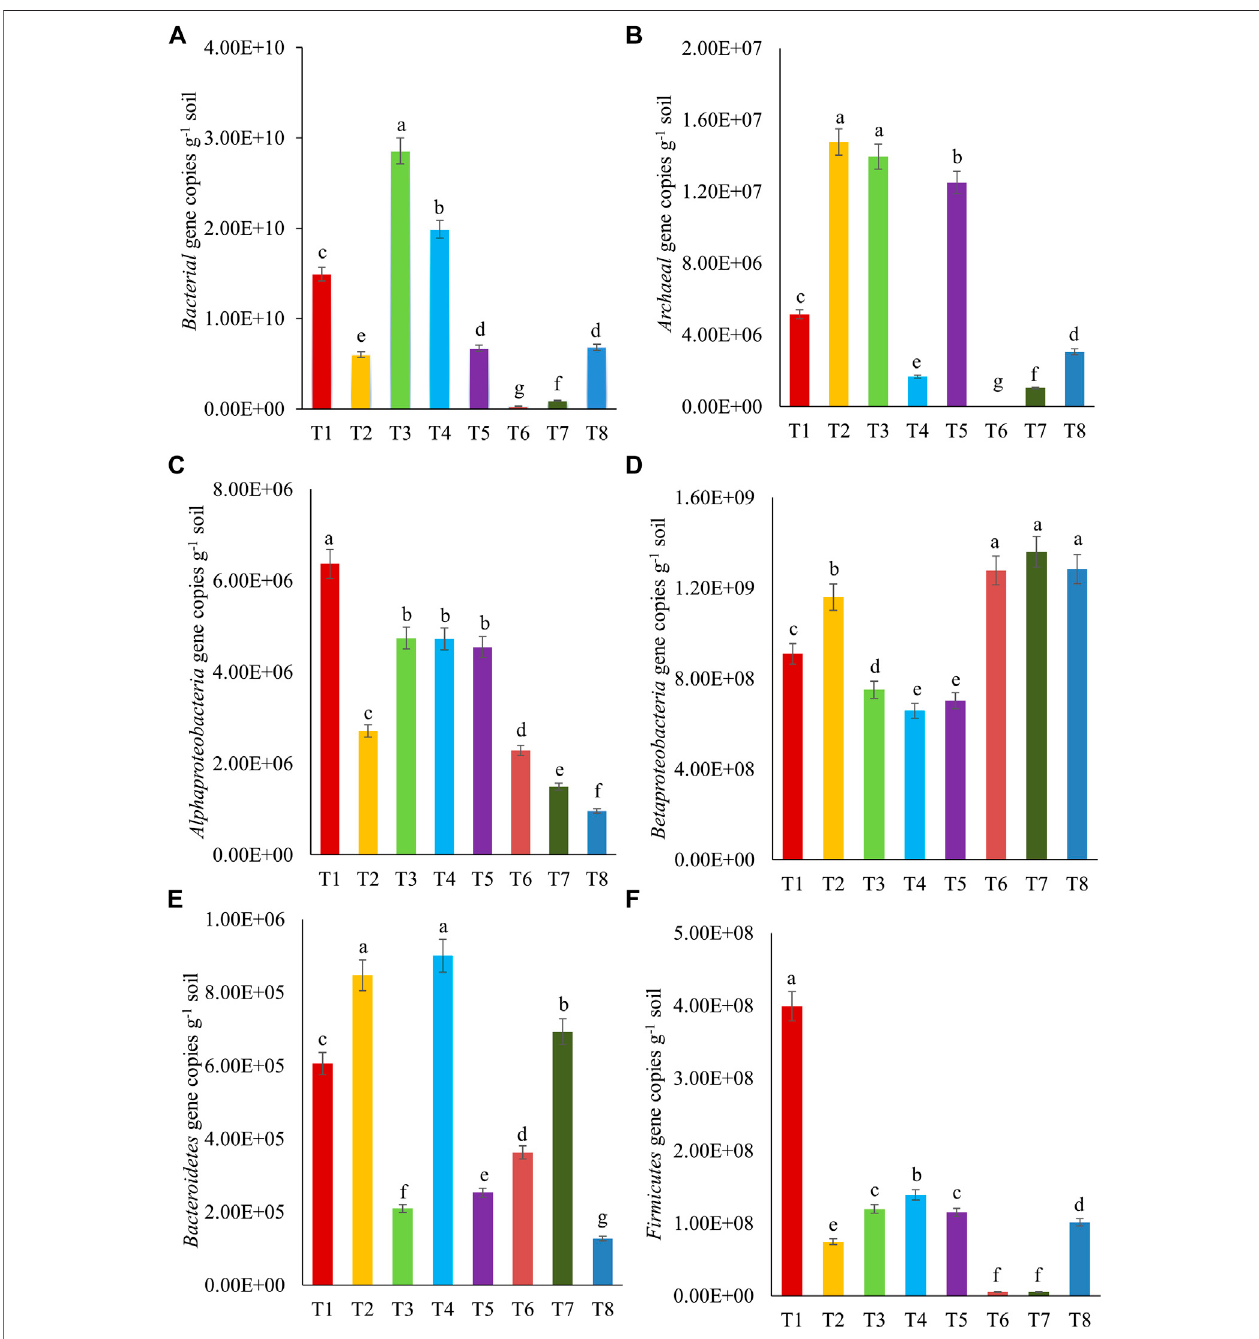
FIGURE 4 | Abundances of 16S rRNA gene copies of (A) Bacteria , (B) Archaea , (C) Alphaproteobacteria , (D) Betaproteobacteria , (E) Bacteroidetes , and (F) Firmicutes after10 th dayofcrudeoilforti fi cationinsandyloamsoil[T1 – soil;T2 – soil+crudeoil(1%);T3 – soil+crudeoil(1%)+bacterialconsortia( Pseudomonas sp.A3+ Bacillus amyloliquefaciens A9); T4 – soil + crude oil (2%) + bacterial consortia ( Pseudomonas sp. A3 + Bacillus amyloliquefaciens A9); T5 – soil + crude oil (5%) + bacterial consortia ( Pseudomonas sp. A3 + Bacillus amyloliquefaciens A9); T6 – soil + crude oil (1%) + fungus ( Aspergillus sydowii AK20); T7 – soil + crude oil (2%) + fungus ( Aspergillus sydowii AK20); T8 – soil + crude oil (5%) + fungus ( Aspergillus sydowii AK20)].